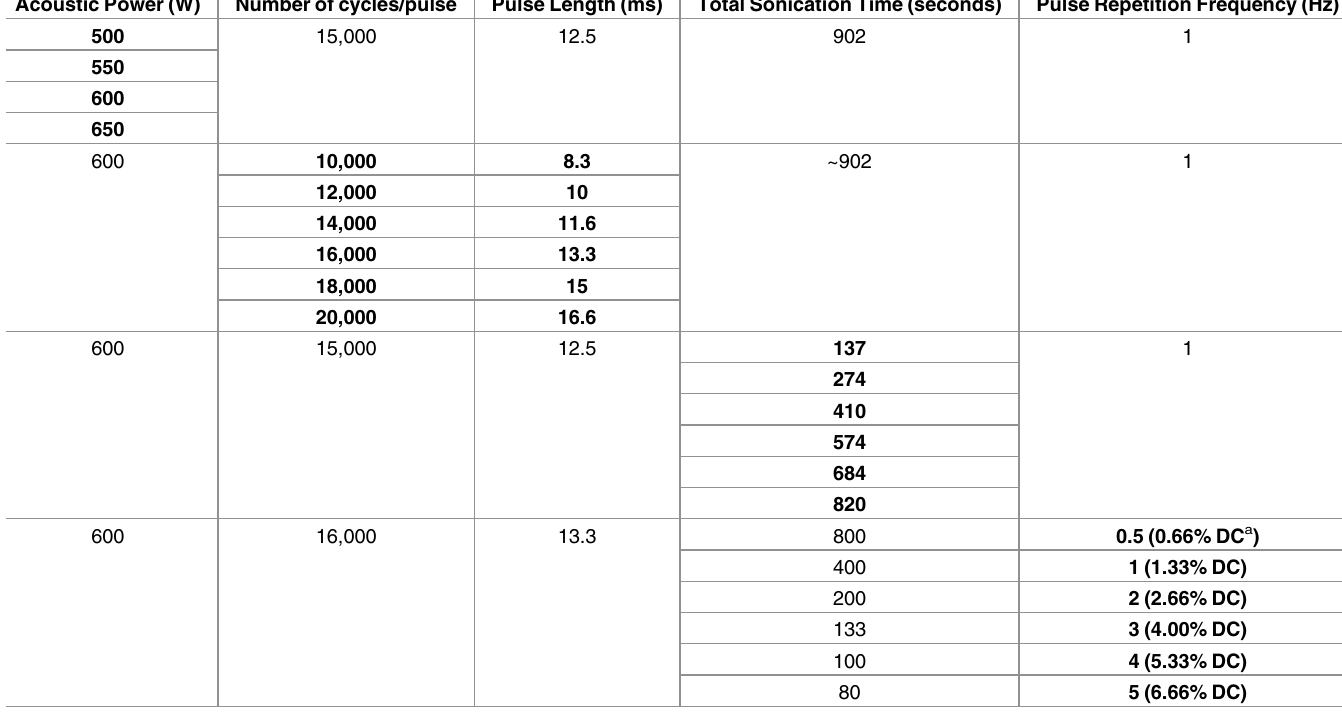
Table 1. List of all sonication parametersused in BH characterization experiments. Four sonicationparameterswere selectedfor this experimental study. While each of these parameters are varied (in bold font), other three parameters are kept constant. Acoustic Power